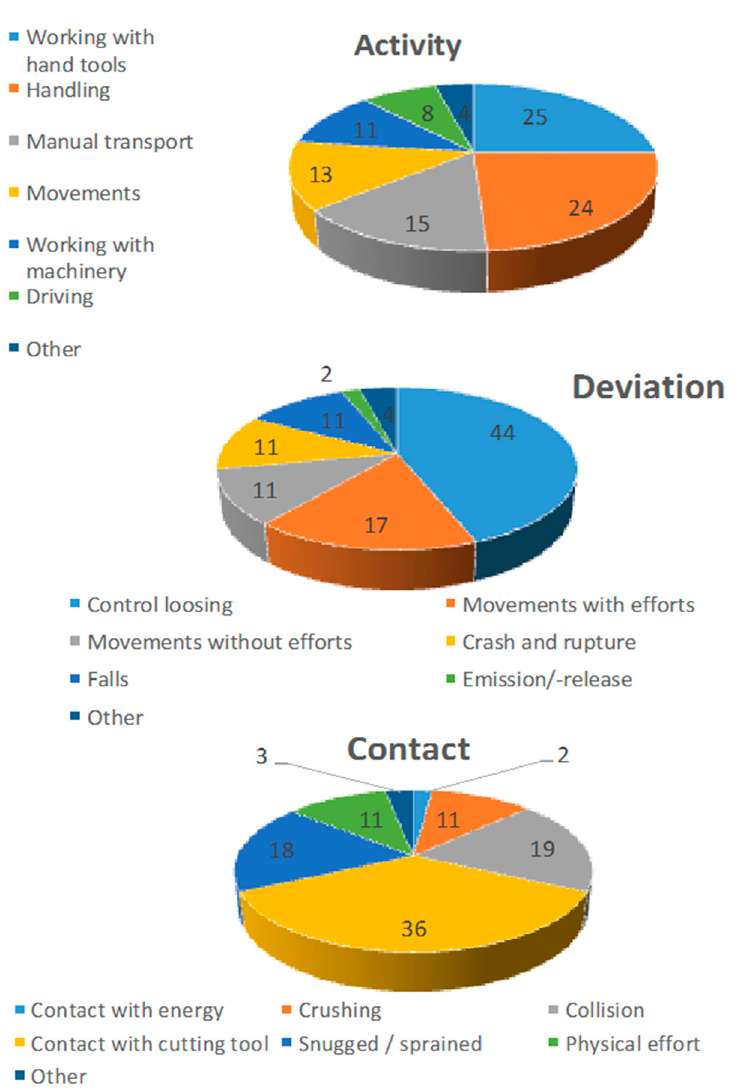
Figure 8. Distribution of the dynamics variables of the wood industry for the Veneto occupational accident database.